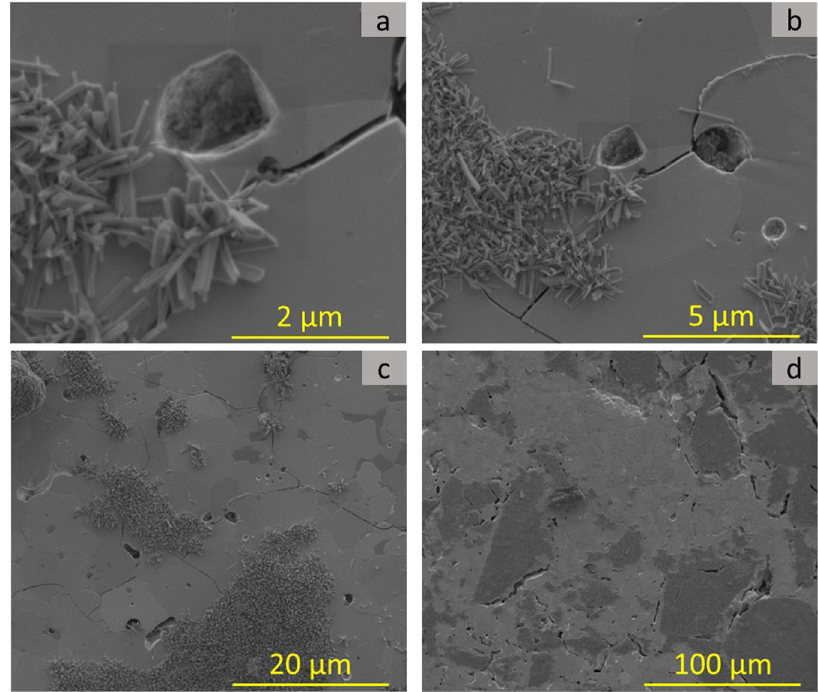
Fig. 6 SEM observations of heterogeneous material after alteration. SEM images (SE mode) of heterogeneous U 0.92 Ce 0.08 O 2 material after leaching in 0.20 mmol.L − 1 H 2 O 2 solution at different magni fi cations a ×25,000; b ×10,000; c ×2500; d